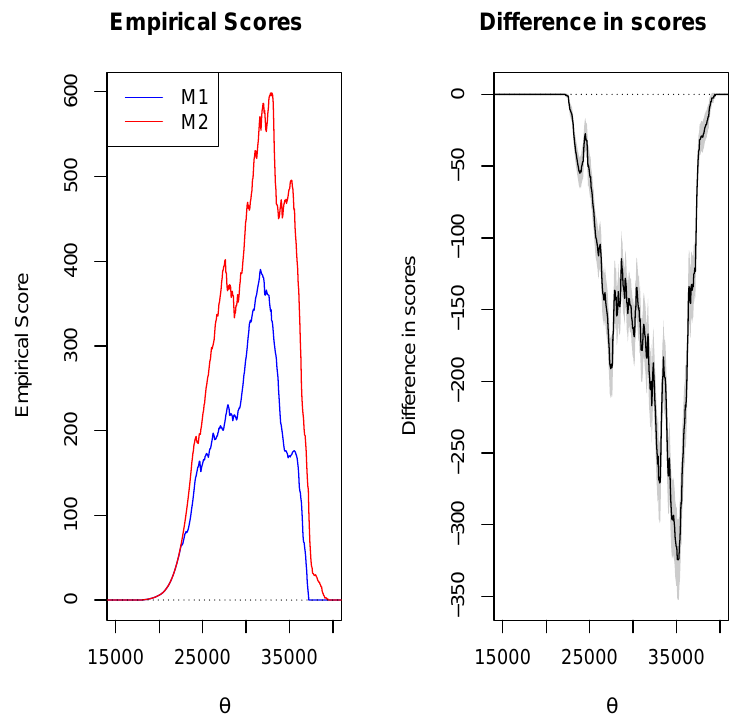
Figure 10. Murphy diagrams for the comparison of the 0.99 quantiles of AQR99 and Extremal99 (M1 and M2).